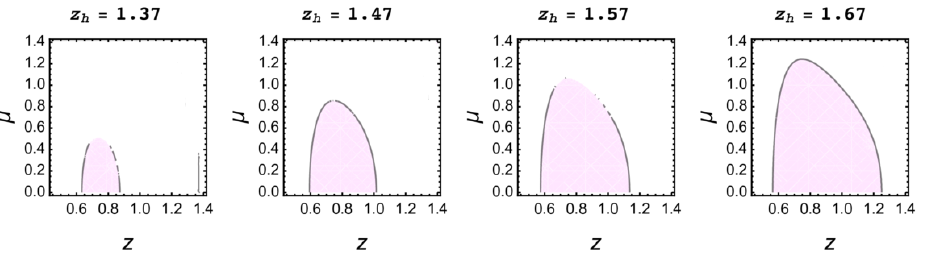
Figure 37 . Contour plots for DW y near zero for di(cid:11)erent z h (labels above).